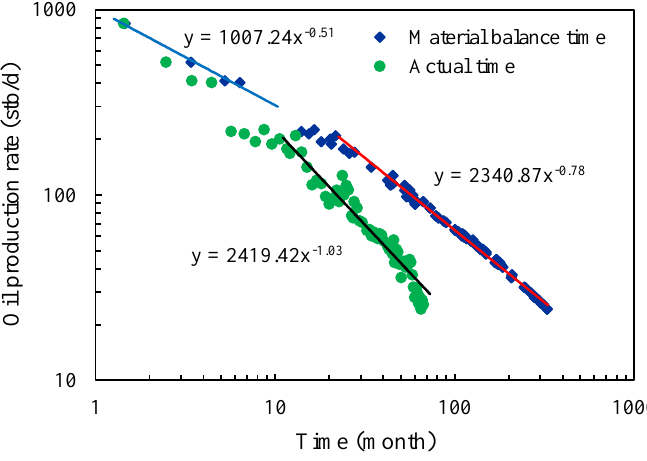
Figure 6. Plot of production rate data for Well #1.